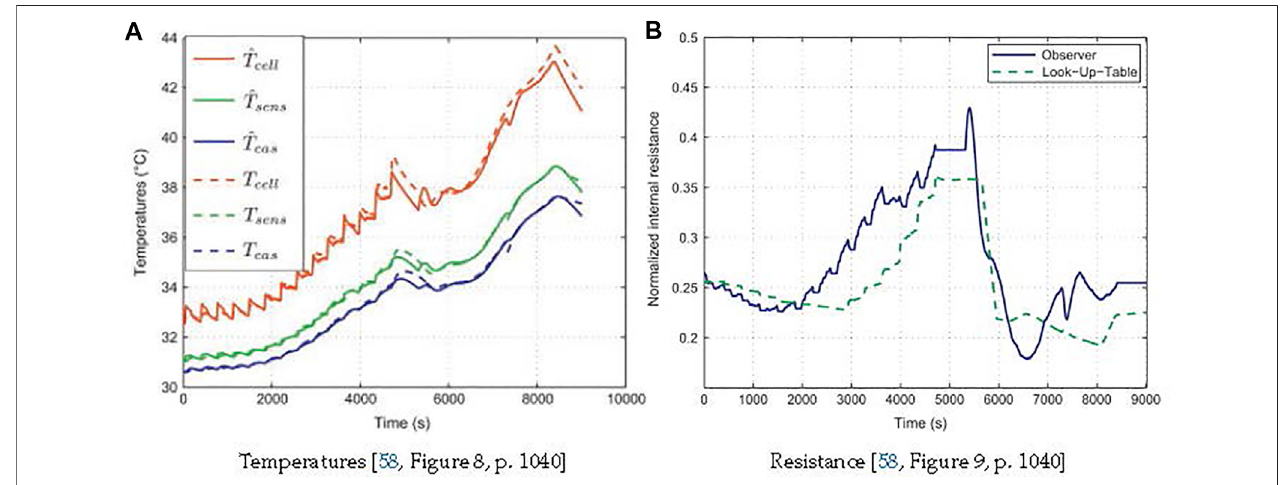
FIGURE9| Theestimationresults, (A) temperatures, (B) internalresistance against theactual values. Internal temperature isdenoted as T cell , surfacetemperature is denoted as T sens and the casing temperature is denoted as T cas . Reprinted from (Debert et al. (2013)), Copyright (2013) with permission from Elsevier.